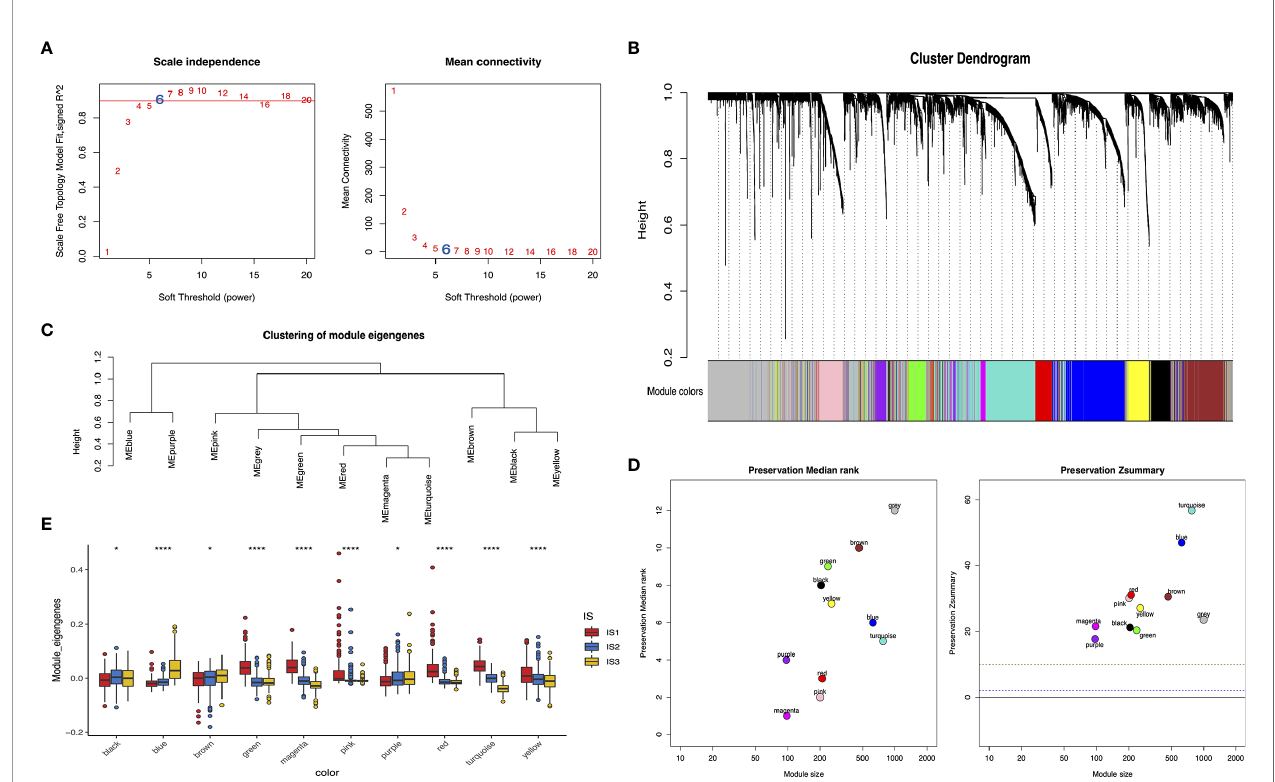
FIGURE 9 | Identi fi cation of immune gene coexpression modules of glioma. Scale-free fi t index for various soft-thresholding powers ( b ) and mean connectivity for various soft-thresholding powers (A) . Dendrogram of all differentially expressed genes clustered based on a dissimilarity measure (1-TOM) (B) . Module eigengenes clustering tree (C) . Module preservation statistics of gene modules. The x-axis presents the module size as the y-axis presents the preservation median rank or preservation Z-summary (D) . Differential distribution of MEs of each module in glioma subtypes (E) . *p < 0.05 and ****p <